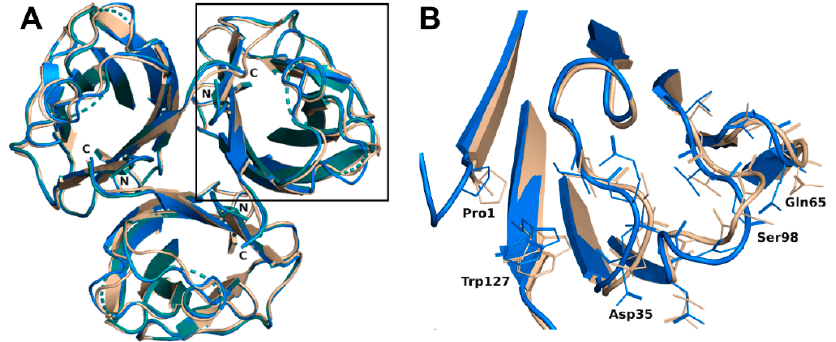
Figure 2. ( A ) Overlay of the overall trimer of rBC2L-CN2 in the complex with H-type 1 (green, 6TID, generated by crystal symmetry) or Globo H (blue, 6TIG) with the original trimer (beige, 2WQ4). ( B ) Zoom on the loop conformation changes observed in the protein chain B in the complex with Globo H.